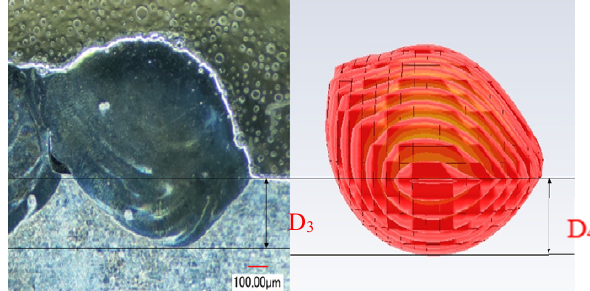
Figure 14. Comparison of experimental and simulated overlapping molten pool morphology.